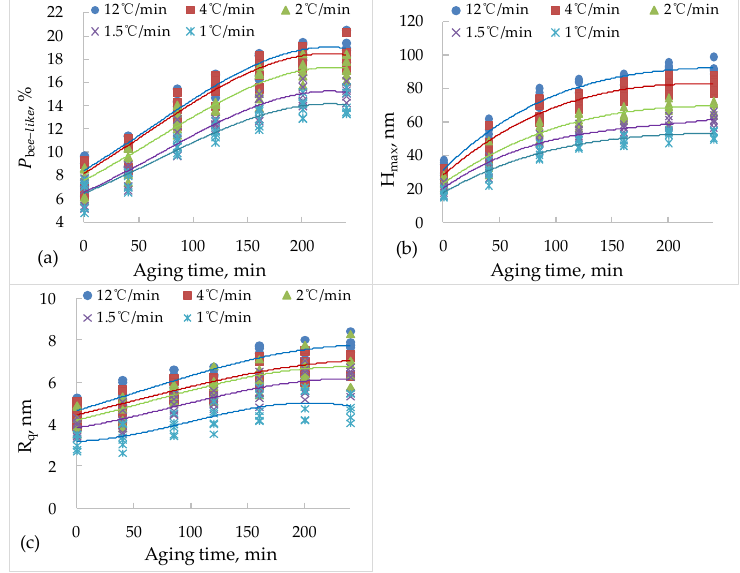
Figure 7. The nano-morphology parameters of bitumen with di ff erent ageing time and cooling rate. ( a ) P bee − like ; ( b ) H max ; ( c ) R q